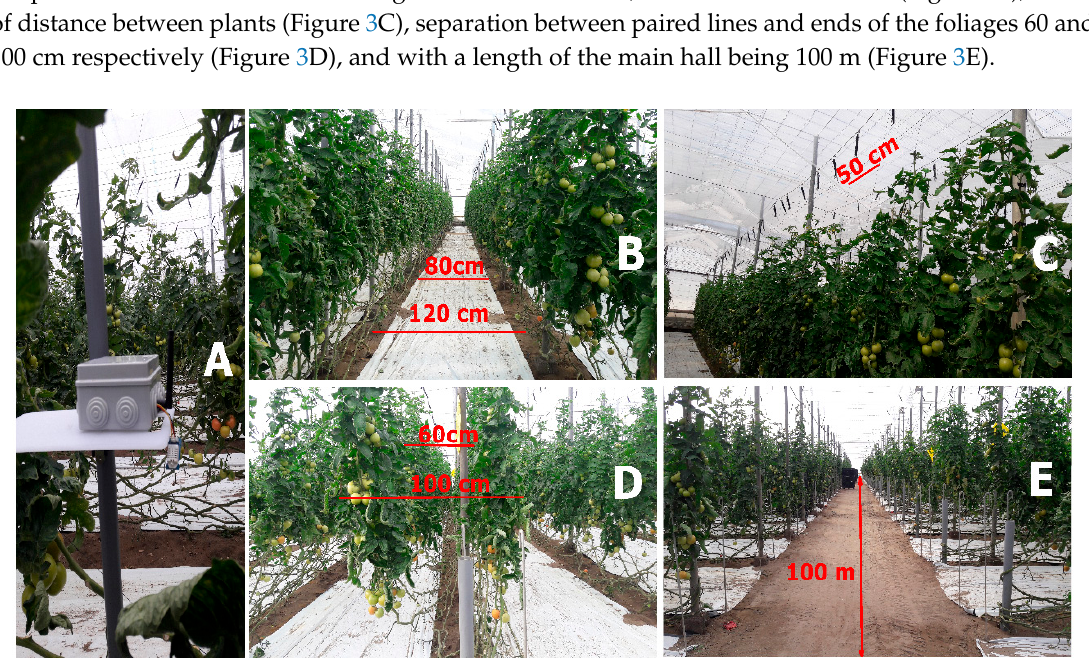
Figure 3. Internal view of the tomato greenhouse in Almeria. ( A ) Sensor node, ( B ) aisle dimensions, ( C ) distance between floors, ( D ) separation of paired lines, ( E ) main hallway measurement.